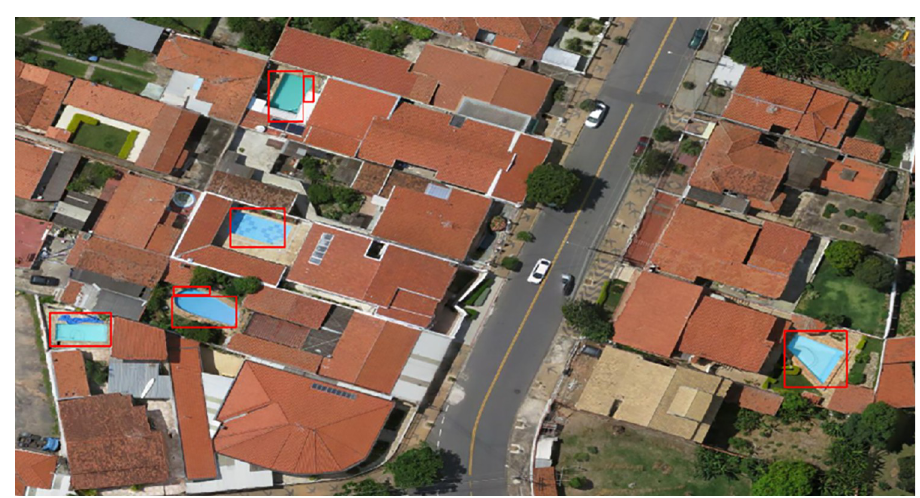
Fig 8. Swimming pools detection in Area 1. Satellite images published under a CC BY license, with permission from G drones, original copyright 2016.